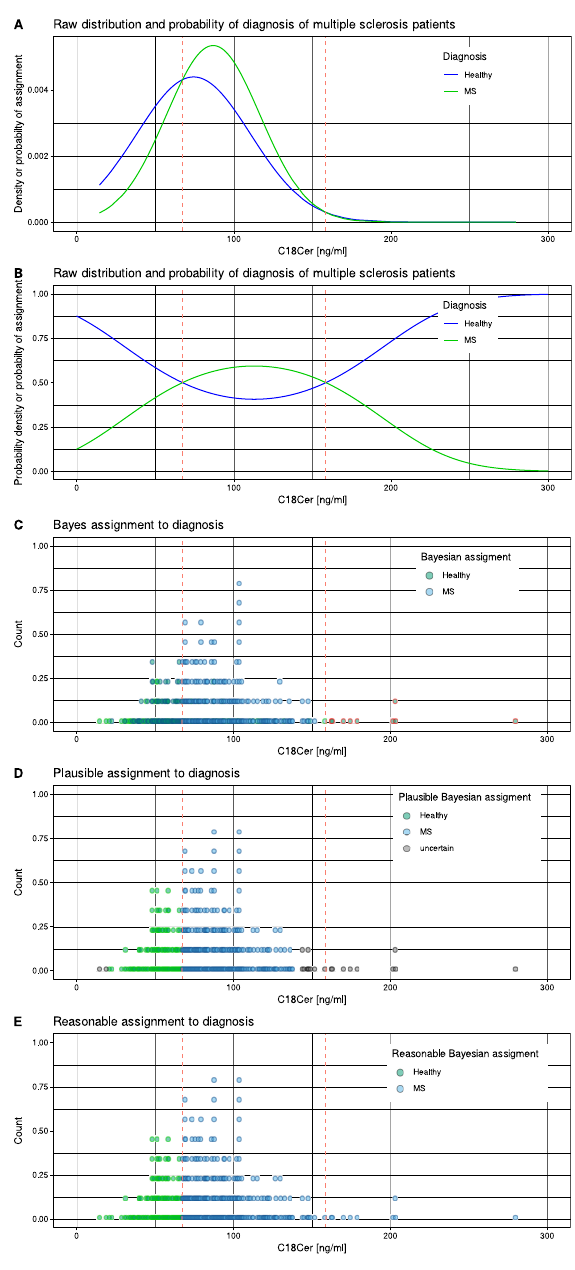
Figure 3. Distribution of serum concentrations of the lipid mediator C18Cer of the ceramide class, as- sayed in the serum of n = 102 patients with multiple sclerosis and n = 301 healthy controls [14]. ( A ) Prob- ability density functions based on observed means and standard deviations of 74.3881 ± 36.2643 ng/mL for patients with multiple sclerosis and 86.8806 ± 29.8202 for healthy subjects. ( B ) Bayesian posterior probabilities for assignment to patients or controls are shown in light blue and red lines. Bayesian decision boundaries are shown as vertical red dashed lines. ( C ) Dot histogram representation of individual cases. Dots are colored for multiple sclerosis or healthy diagnosis based on Bayesian poste- riors in panel B. ( D ) According to the “reasonable Bayes” method proposed in this report, cases with uncertain class assignment were identified, which occurred in marginal areas where the probability density functions of the data set instances were very low. ( E ) For cases that were not classified by the above method, assignment to clinical diagnosis group was based on the “plausible Bayes” method proposed in this report. The figure has been created using the R software package (version 4.1.3 for Linux; https://CRAN.R-project.org/ (accessed on 18 September 2022) [12]) and the R library “ggplot2” (https://cran.r-project.org/package=ggplot2 (accessed on 18 September 2022)